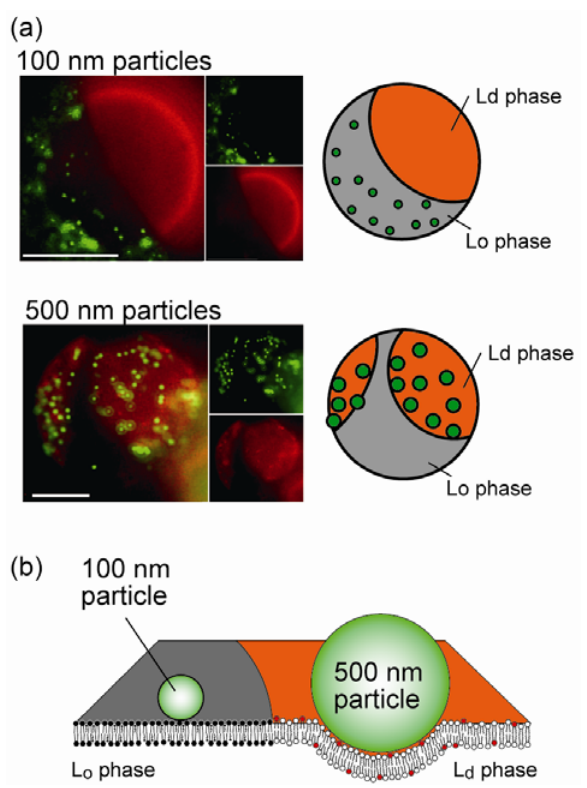
Figure 3. ( a ) Typical images of the localization of nanoparticles (NPs) with diameters of 100 and 500 nm on heterogeneous bilayer membranes. Scale bars are 10 µm; ( b ) Schematics of the size-dependent selective localization of NPs. Reprinted with permission from [33]. Copyright 2010 American Chemical